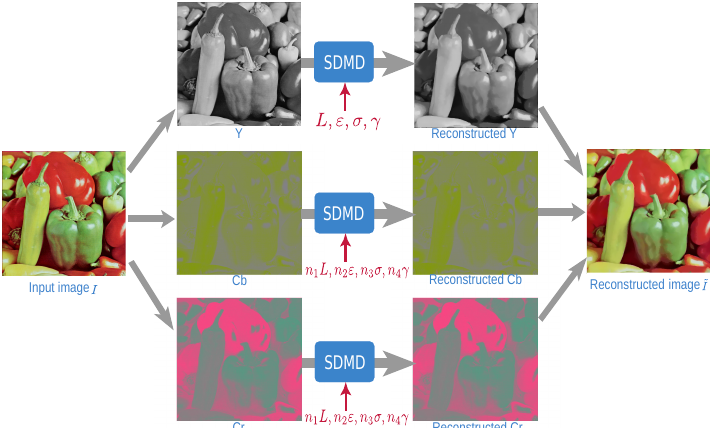
Figure 4. SDMD computation framework for color images. The red parameters indicate SDMD treats chrominance (Cb and Cr components) and luminance (Y component)